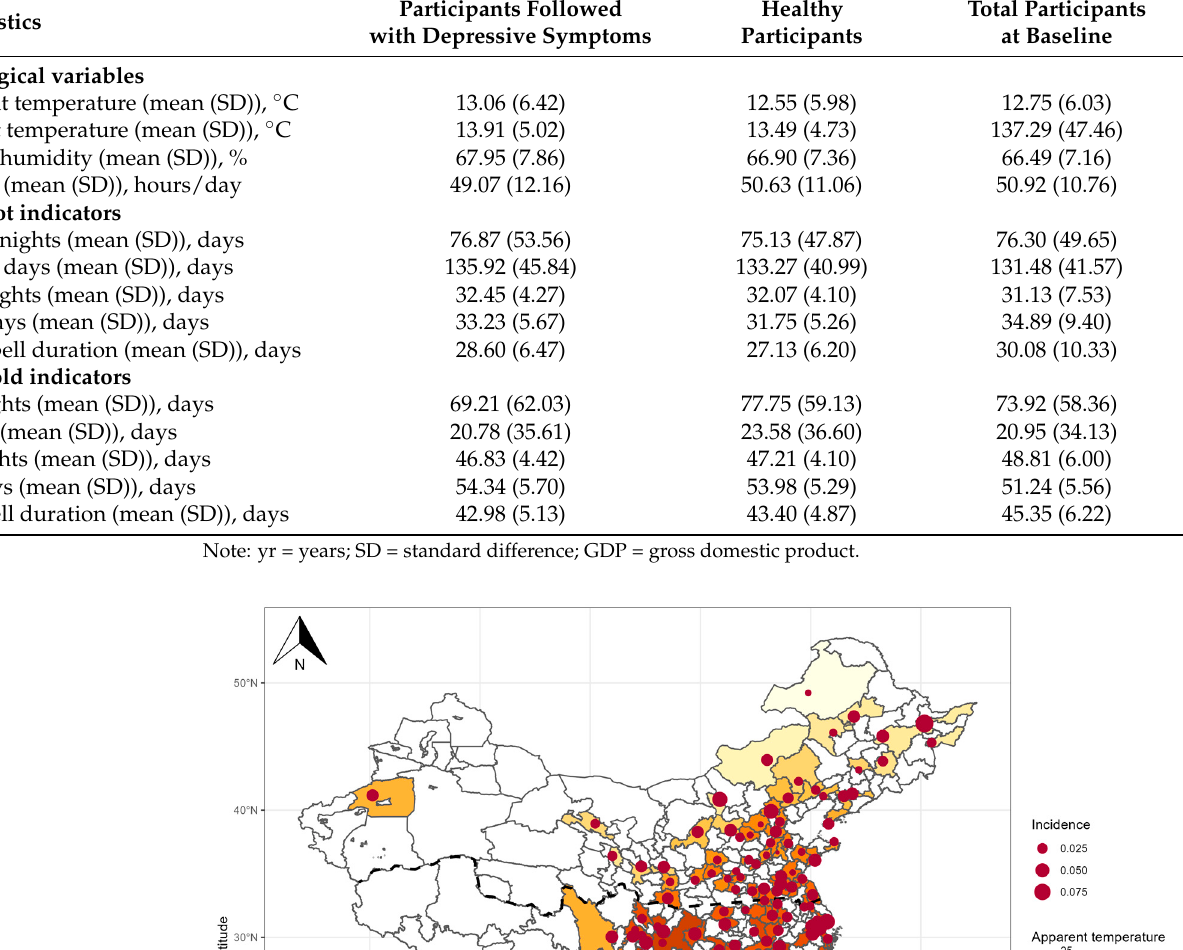
Figure 2. The exposure − response curve of long-term temperature exposure and depressive symp- toms. Age, sex, marriage status, household income, education attainment, urbanicity of residence, gross domestic product (GDP), and annual average sunlight hours were adjusted. The solid line represents log hazard ratio, and gray zone indicates 95% confidence interval.